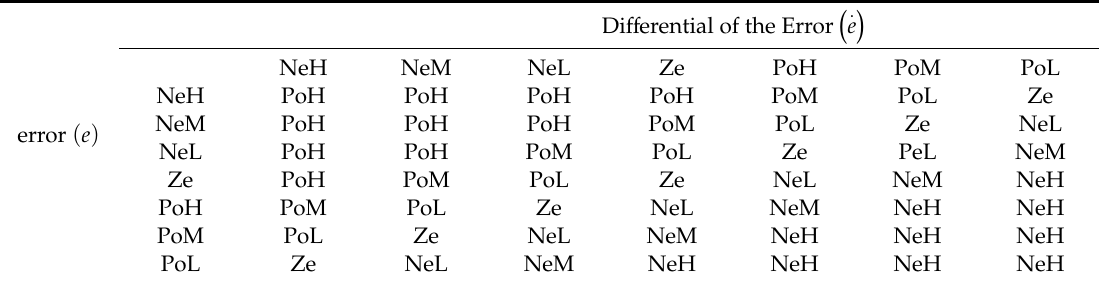
Table 2. The proportional and derivative (PD) fuzzy rule table for the fuzzy backstepping variable structure controller